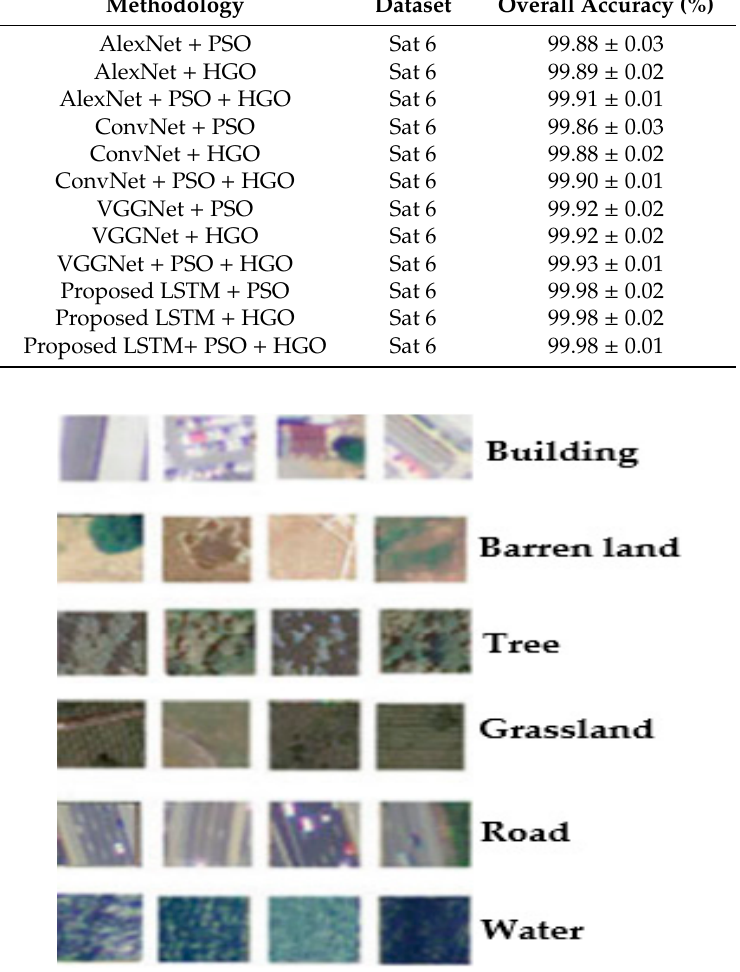
Figure 13. Sample image patches of Sat 6 dataset.